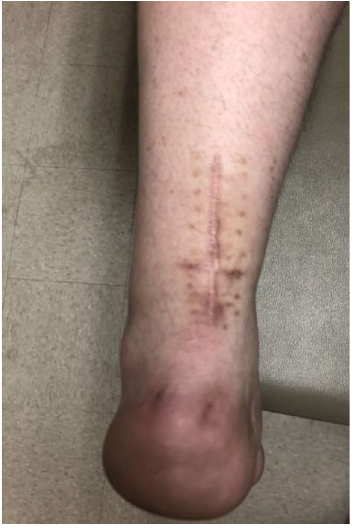
Figure 5: Six months postoperative visit from revision